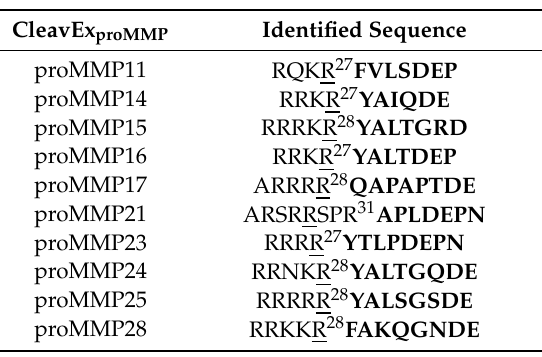
Table 1. Identification of the KLK14 hydrolysis sites within the CleavEx proMMP protein. CleavEx proMMP fusion proteins were separated using SDS-PAGE and electrotransferred for N-terminal sequencing. Identified sequences are represented in the bold font and the underscore denotes where the location of the expected activation cleavage P1-P1 (cid:48) in the proMMP-derived